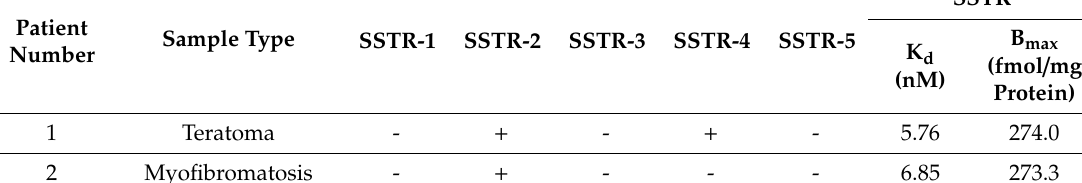
Table 1. Expression of mRNA for somatostatin receptor subtypes (SSTR-1–5) and binding characteristic of somatostatin receptors in pediatric hematological and oncological